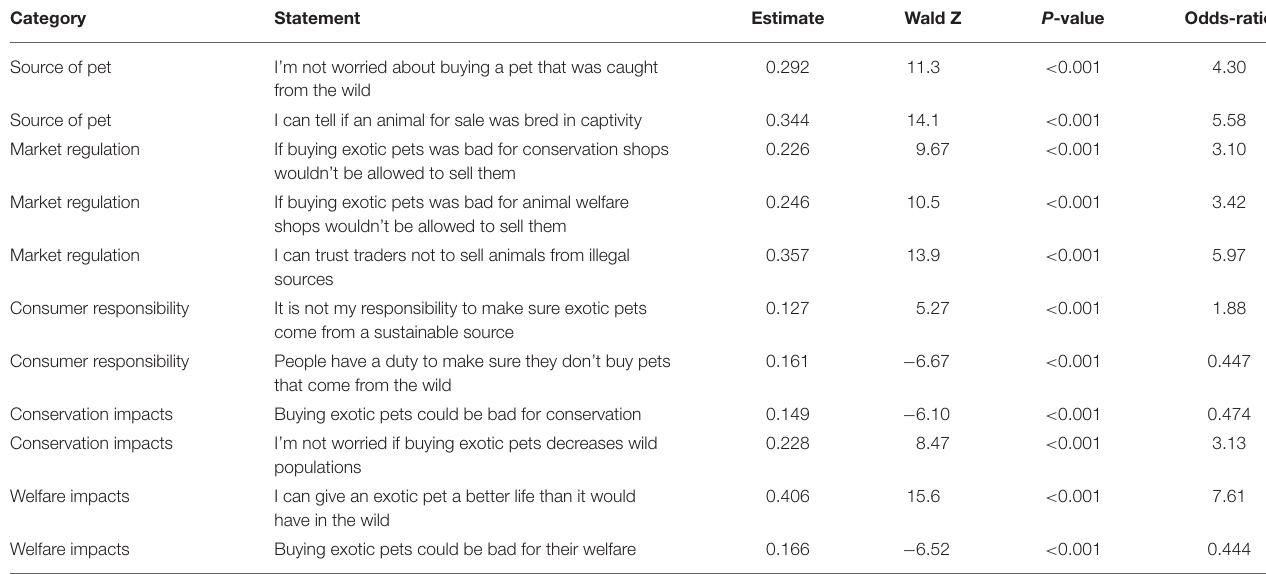
TABLE 1 | Attitudinal statements, and the effect of respondents’ stated likelihood of future purchase on their level of agreement with these